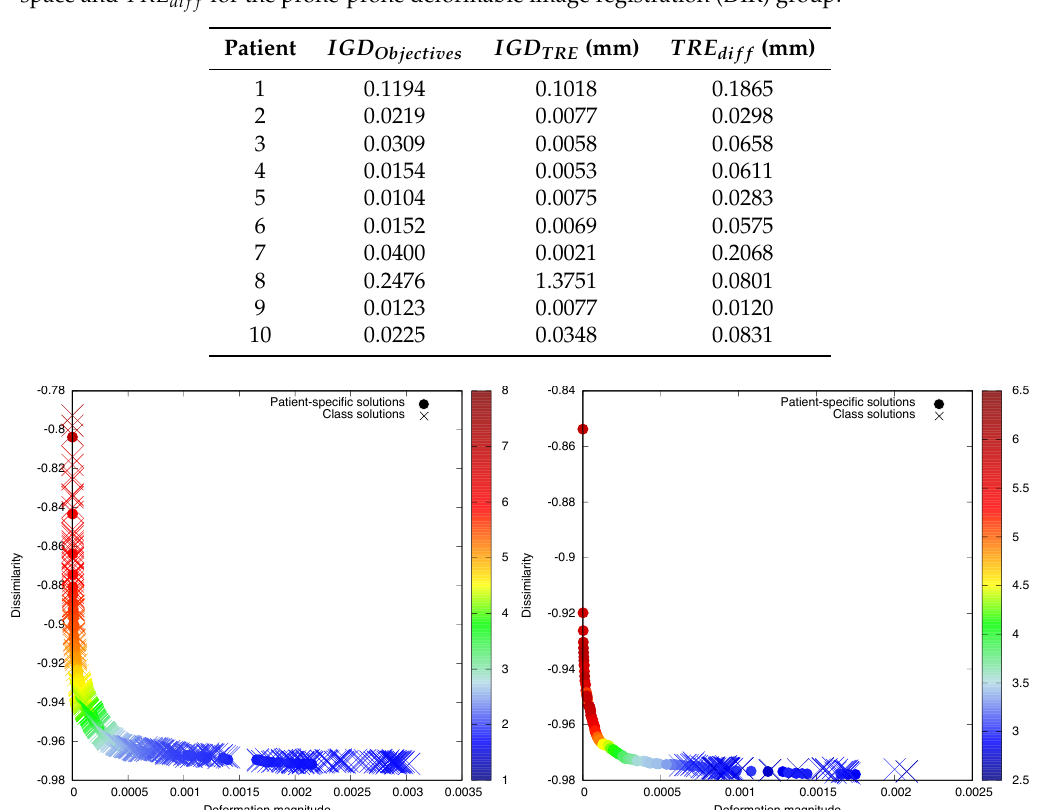
Table 1. Inverted generational distance (IGD) values in objective and target registration error (TRE) space and TRE dif f for the prone-prone deformable image registration (DIR) group.